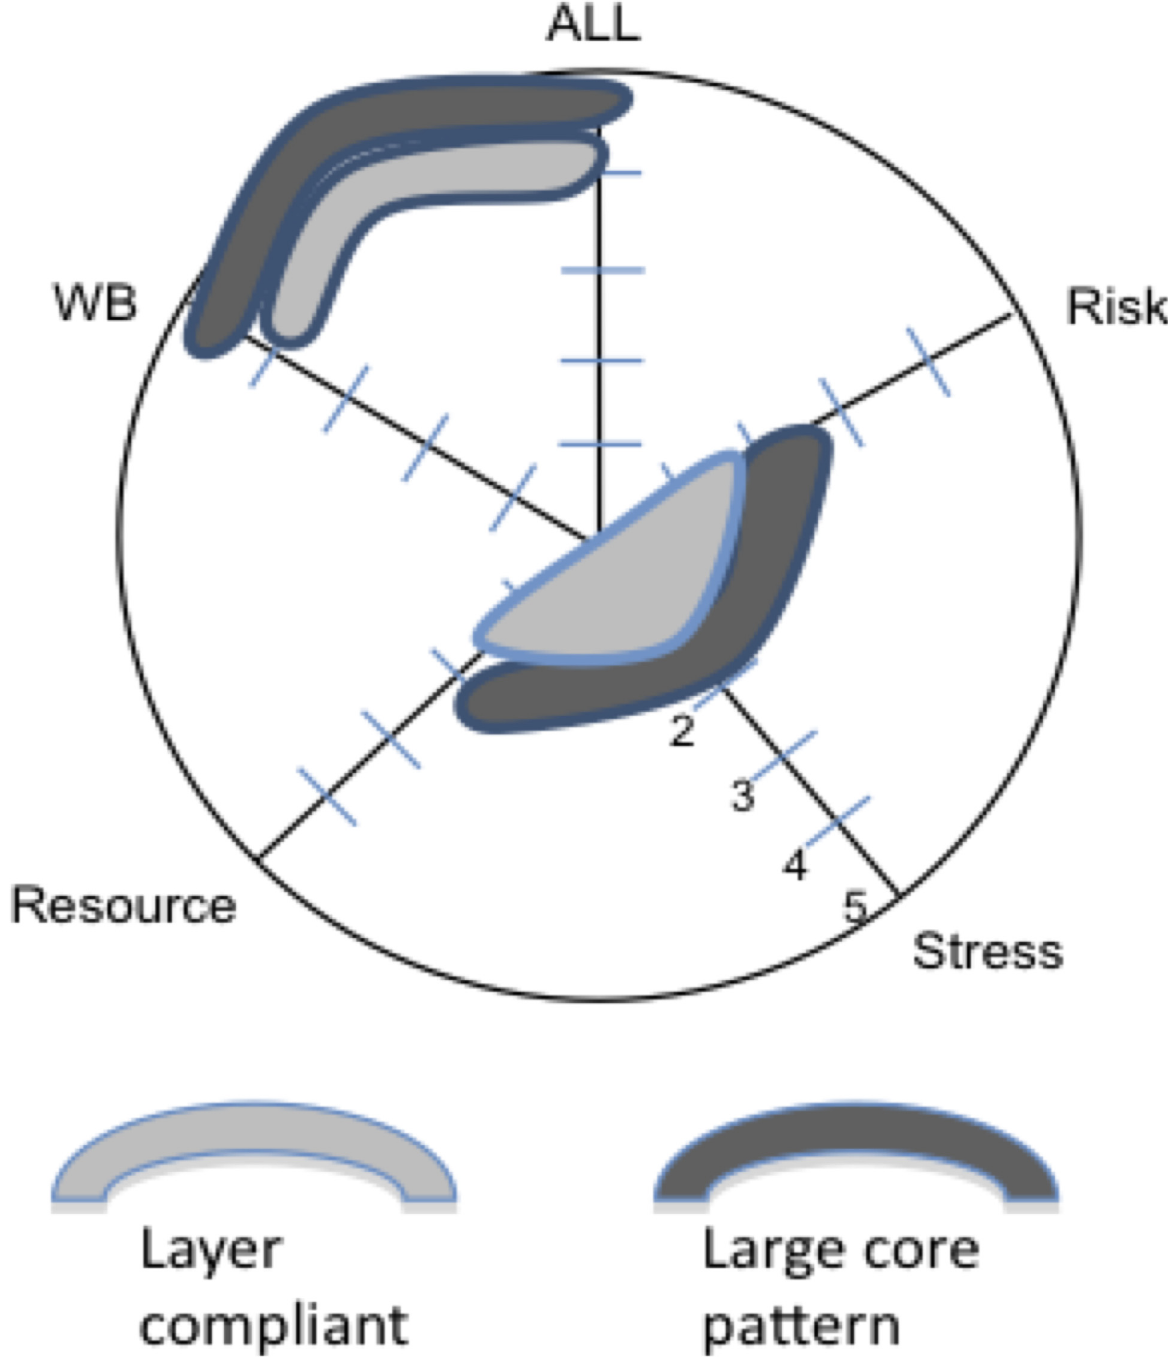
Fig 2. Locus of the layer-compliant and large core patterns in the space of fitness criteria weights. Dark shading indicates the layer-compliant pattern, lighter shading the many strong ties pattern. All = Alliance, WB = Wellbeing fitness criteria. Weights increase towards the circumference of the